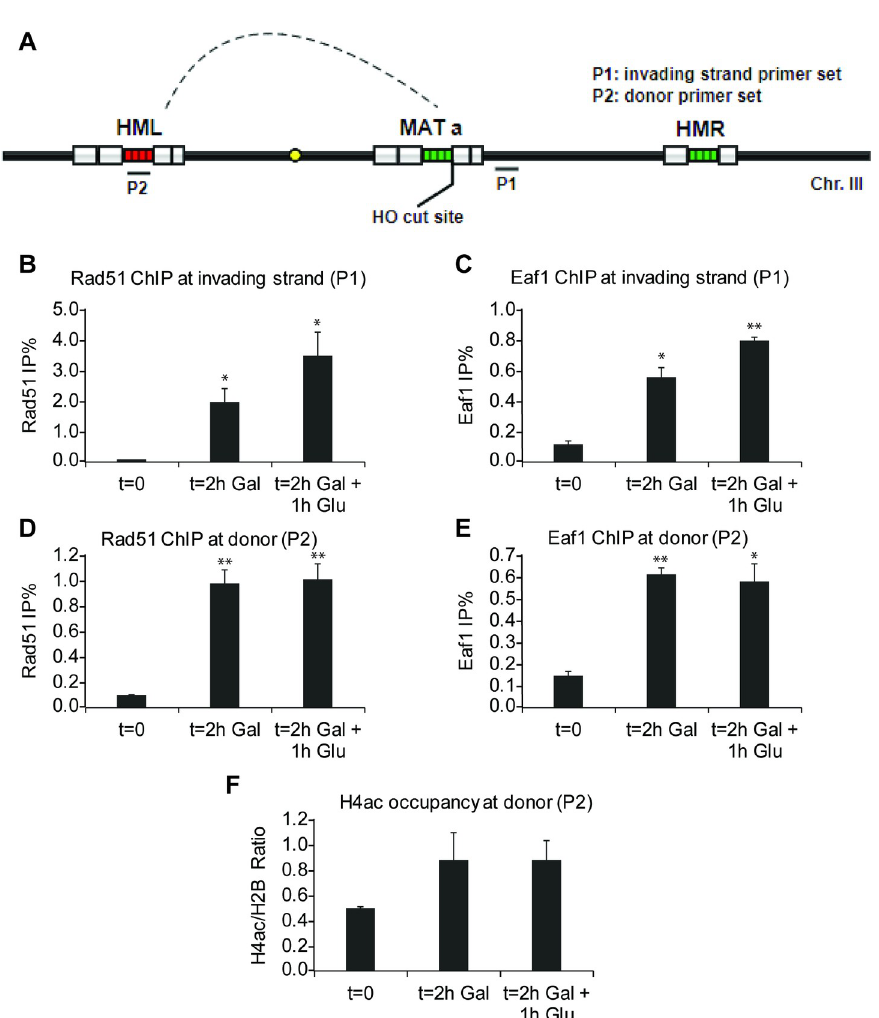
Fig 3. NuA4 functions at the donor homologous sequence during HR, implicating chromatin acetylation during D-loop formation. A) Schematic representation of HR donor strain genome arrangement and primer positions for ChIP-qPCR. B-E) ChIP-qPCR assay (% of Ip/input) of Rad51 (B, D) and Eaf1 (C, E) in HR donor strain after 0, 2hr galactose induction or 2hr galactose induction followed 1hr glucose (2%) treatment to block HO nuclease expression. Rad51 and NuA4 are clearly recruited at both the invading strand from the HO cut and and at the donor sequence during HR. Error bars represent range from biological duplicates. F) ChIP-qPCR of NuA4-dependent H4 acetylation at the donor sequence (H4ac/total H2B ratio of %IP/input), showing a clear increase during HR. Error bars represent standard error from biological triplicates. (Statistical analyses were performed by one-tailed t-test: � p < 0.05, �� p < 0.01, ��� p < 0.001; and multiple comparisons significance was also confirmed by one-way ANOVA followed by Tukey test).